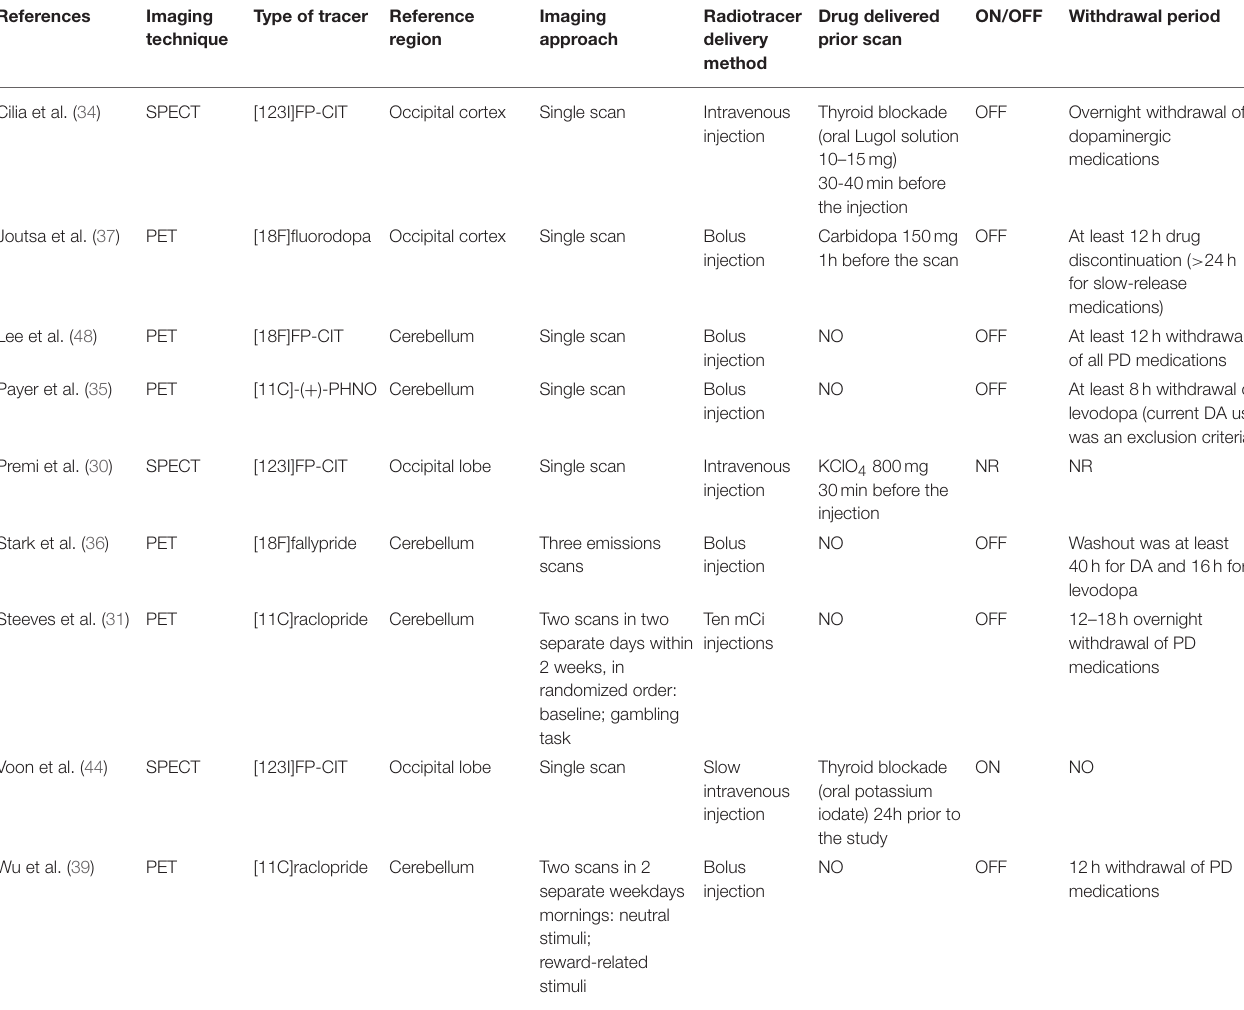
TABLE 2 | Methodological characteristics of the studies included in the